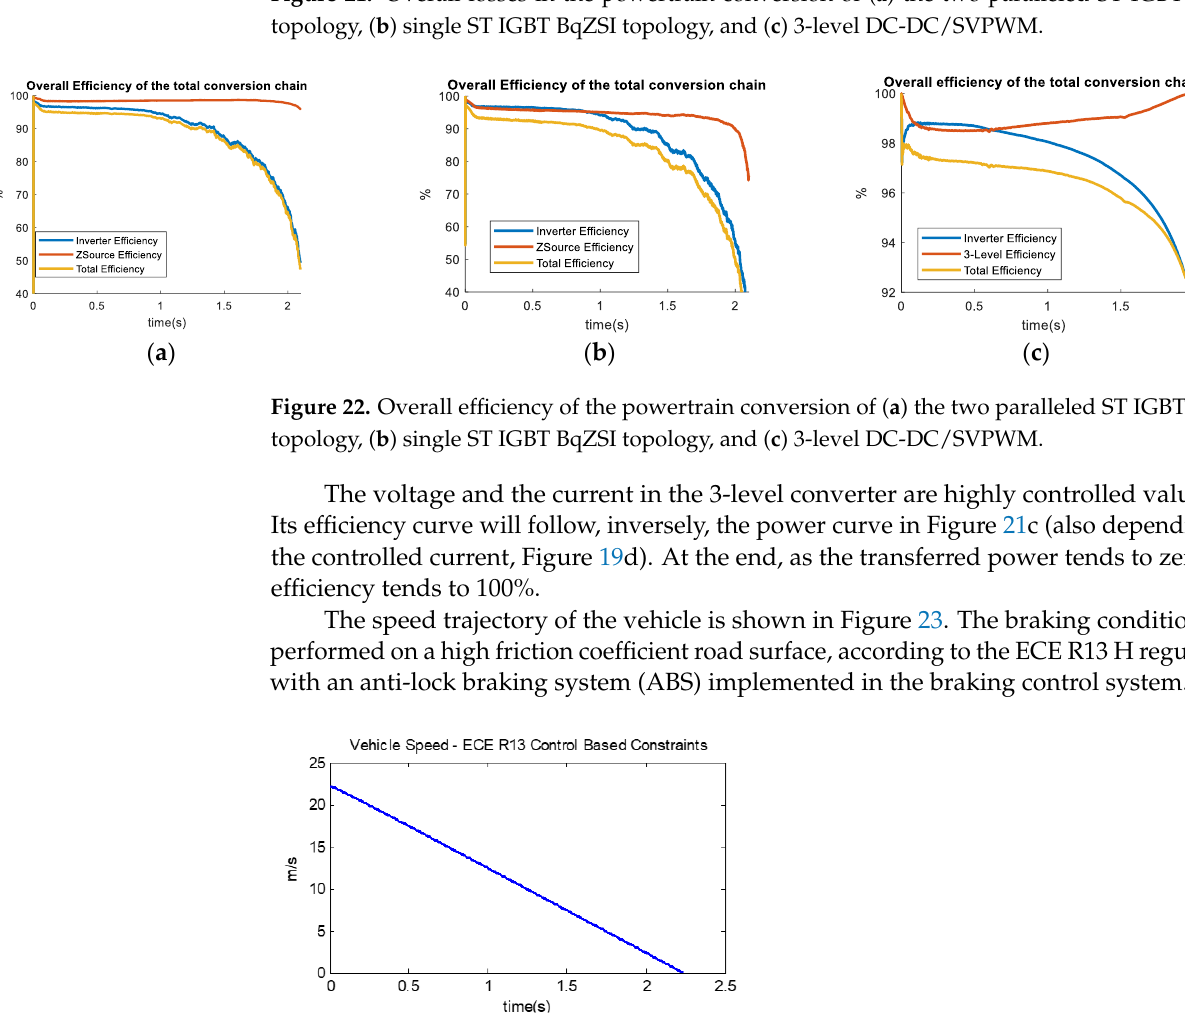
Figure 23. Speed trajectory (in m/s) for high friction coefficient road surface.